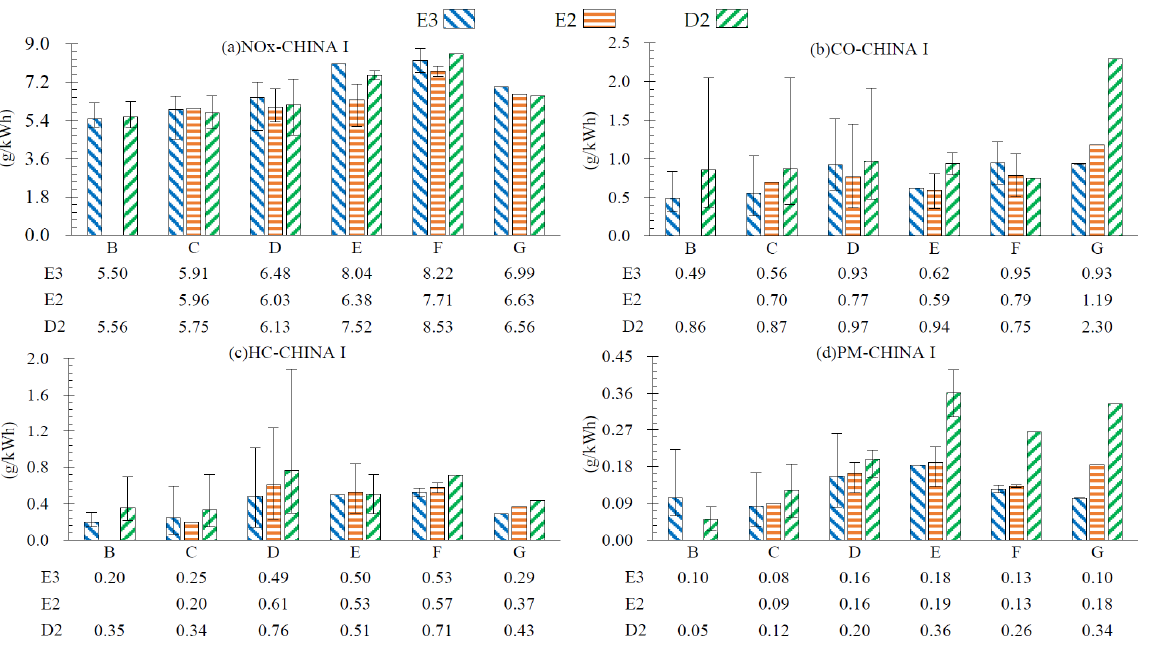
Figure 4. Energy-based emission factors for different single-cylinder displacements under the CHINA I standard. ( a ) NOx-specific emissions in the E3, E2, and D2 cycles; ( b ) CO-specific emissions in the E3, E2, and D2 cycles; ( c ) HC-specific emissions in the E3, E2, and D2 cycles; ( d ) PM-specific emissions in the E3, E2, and D2 cycles.